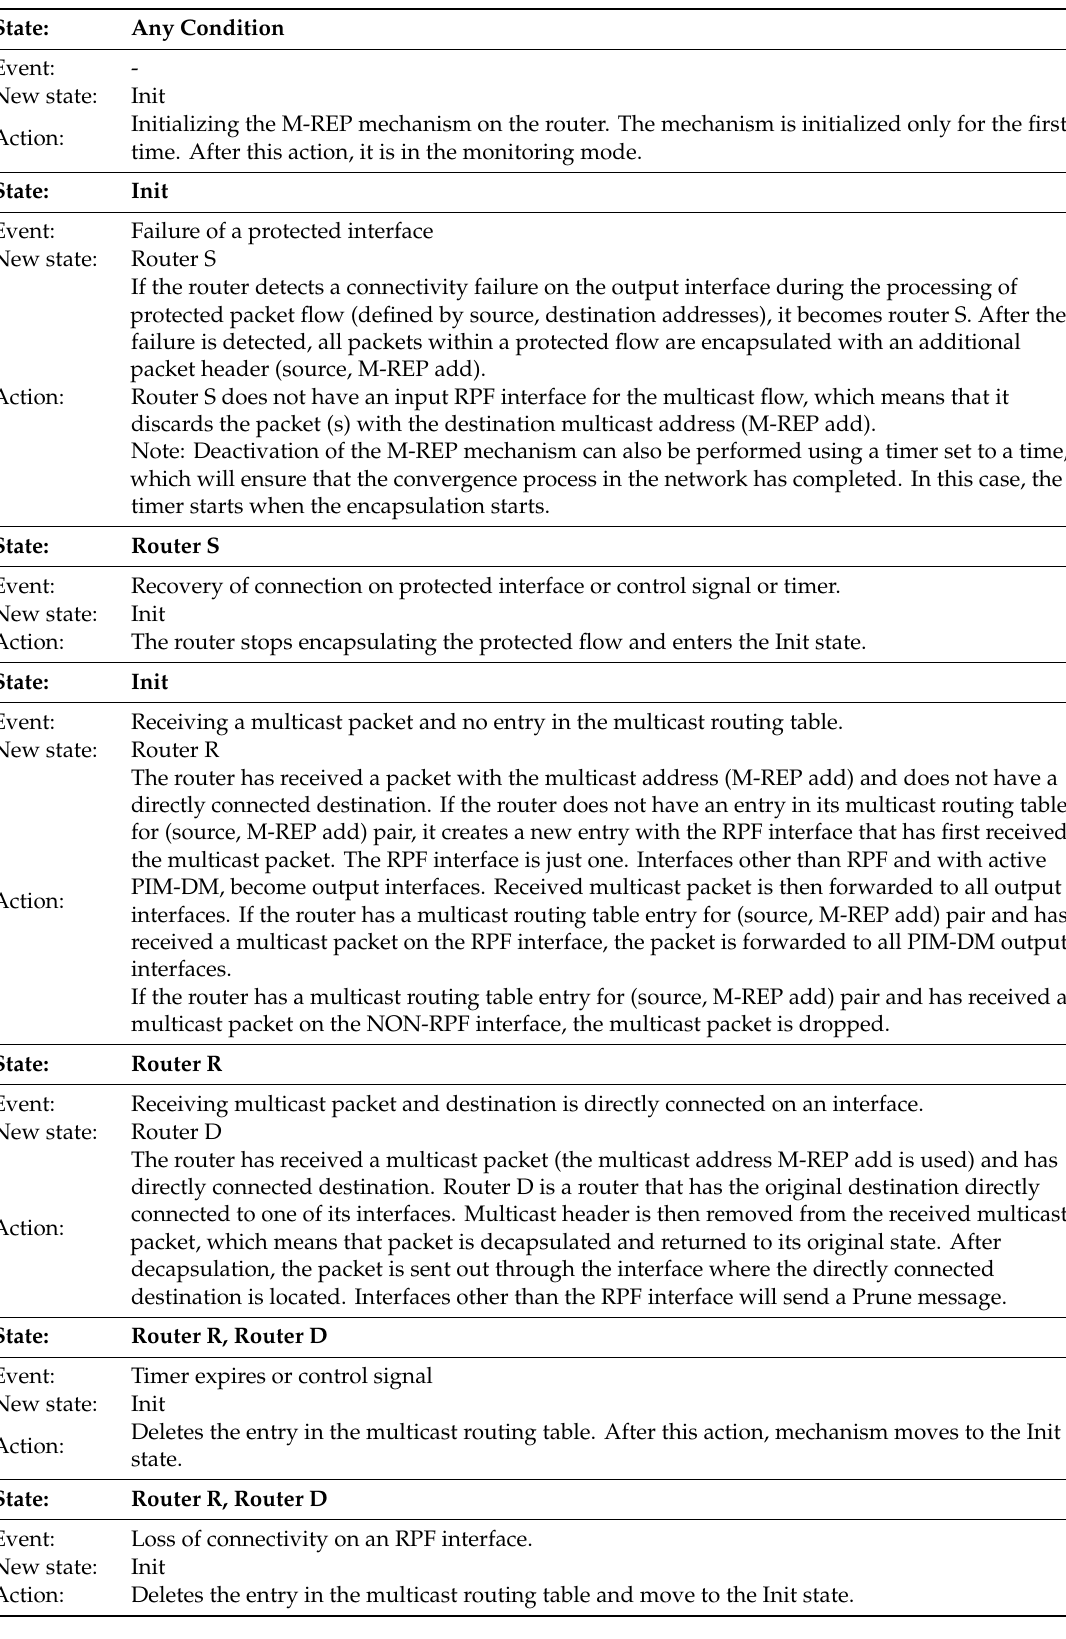
Table 3. States of the M-REP